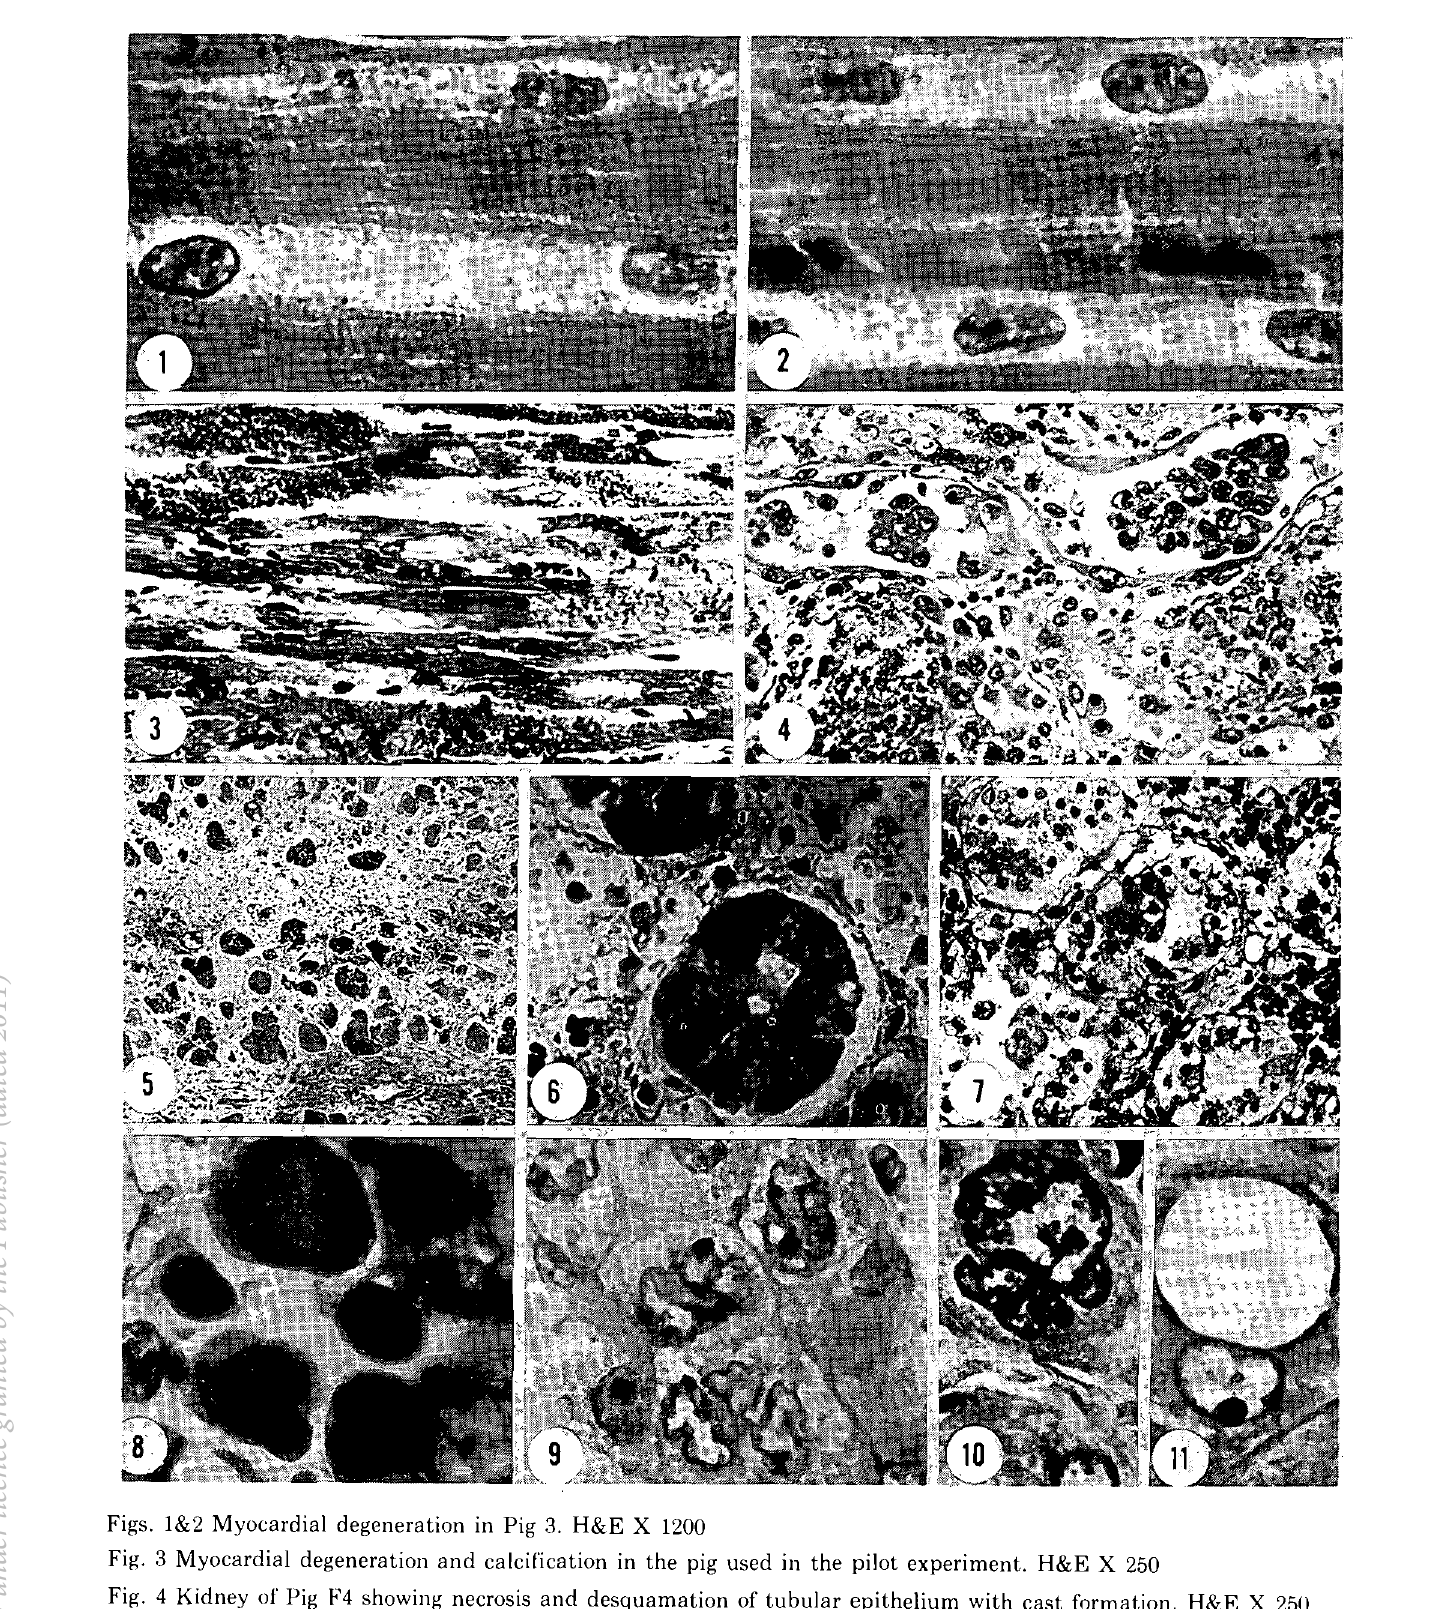
Figs. 1&2 Myocardial degeneration in Pig 3. H&E X 1200 Fig. 3 Myocardial degeneration and calcification in the pig used in the pilot experiment. H&E X 250 Fig. 4 Kidney of Pig F4 showing necrosis and desquamation of tubular epithelium with cast formation. H&E X 250 Fig. 5 Liver of Pig F6 showing grouping of hepatocytes into acinar structures. H&E X 80 Fig. 6 Higher magnification of Fig. 5. H&E X 250 Fig. 7 Liver of the pig used in the pilot experiment showing acinar arrangement of hepatocytes. H&E X 250 Fig. 8 Large eosinophilic globules in hepatocytic cytoplasm of Pig F3. H&E X 1200 Fig. ~) Crenated nuclei with nuclear division in Pig F5. H&E X 1200 Fig. 10 Large "budding" nucleus from the kidney of Pig F4. H&E X 1200 Fig. II Binucleate hepat.ocyte with one large vesicular nucleus in Pig F3. H&E X